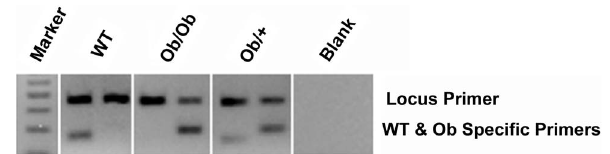
Figure 3. Confirmation of HRM results by alternate gel-based methods. Locus specific control band at 191 bp in all lanes, wt specific band at 104 bp in 1 st lane and Lep ob specifc band at 123bp in 2 nd lane of pairs.